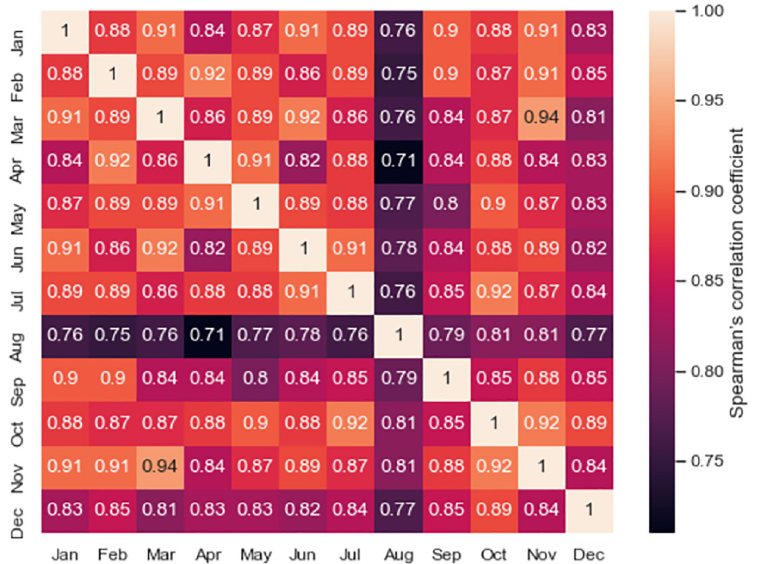
Fig 5. Spearman’s rank-order correlation coefficient of the FMD SSBR computed for pairs of months in 2016. High values on this measure represent high stable ranks.